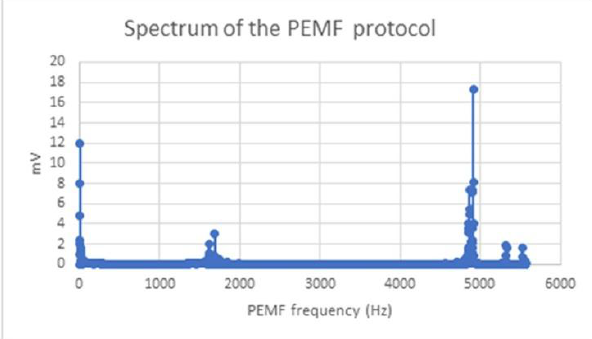
Figure 3 : Spectrum of the pulsed electromagnetic field (PEMF) excitation protocol (by Fast Fourier Transform of the EMF profile recorded on an oscilloscope). Hz: Hertz.